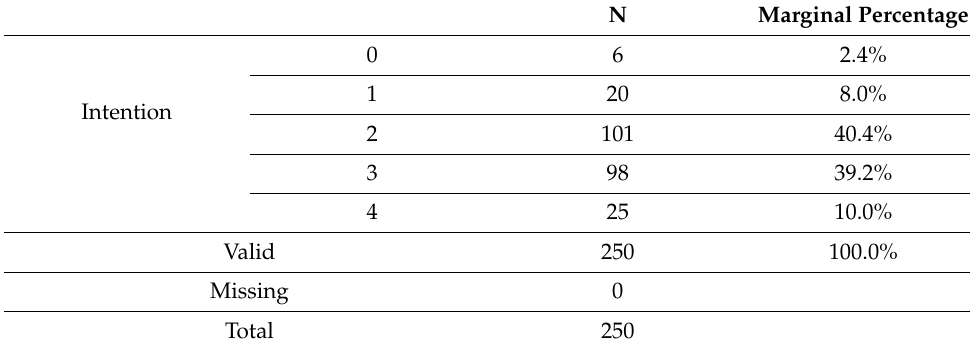
Table 7. Summary of Case